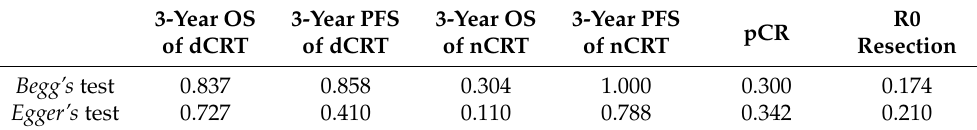
Table 2. Symmetry test of funnel